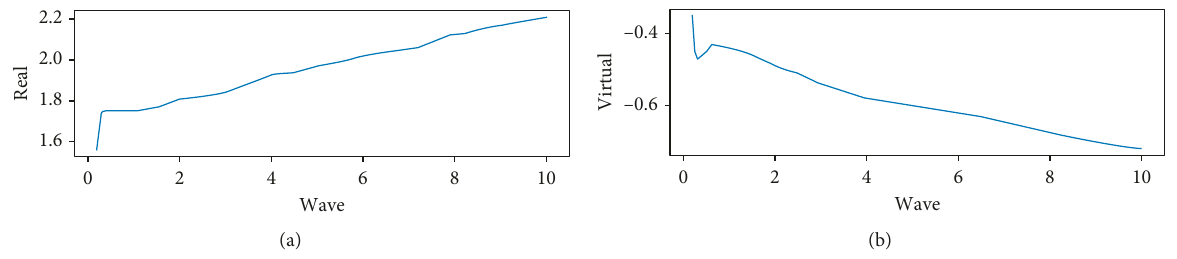
F IGURE 1: Complex refractive index of BC aerosols in different